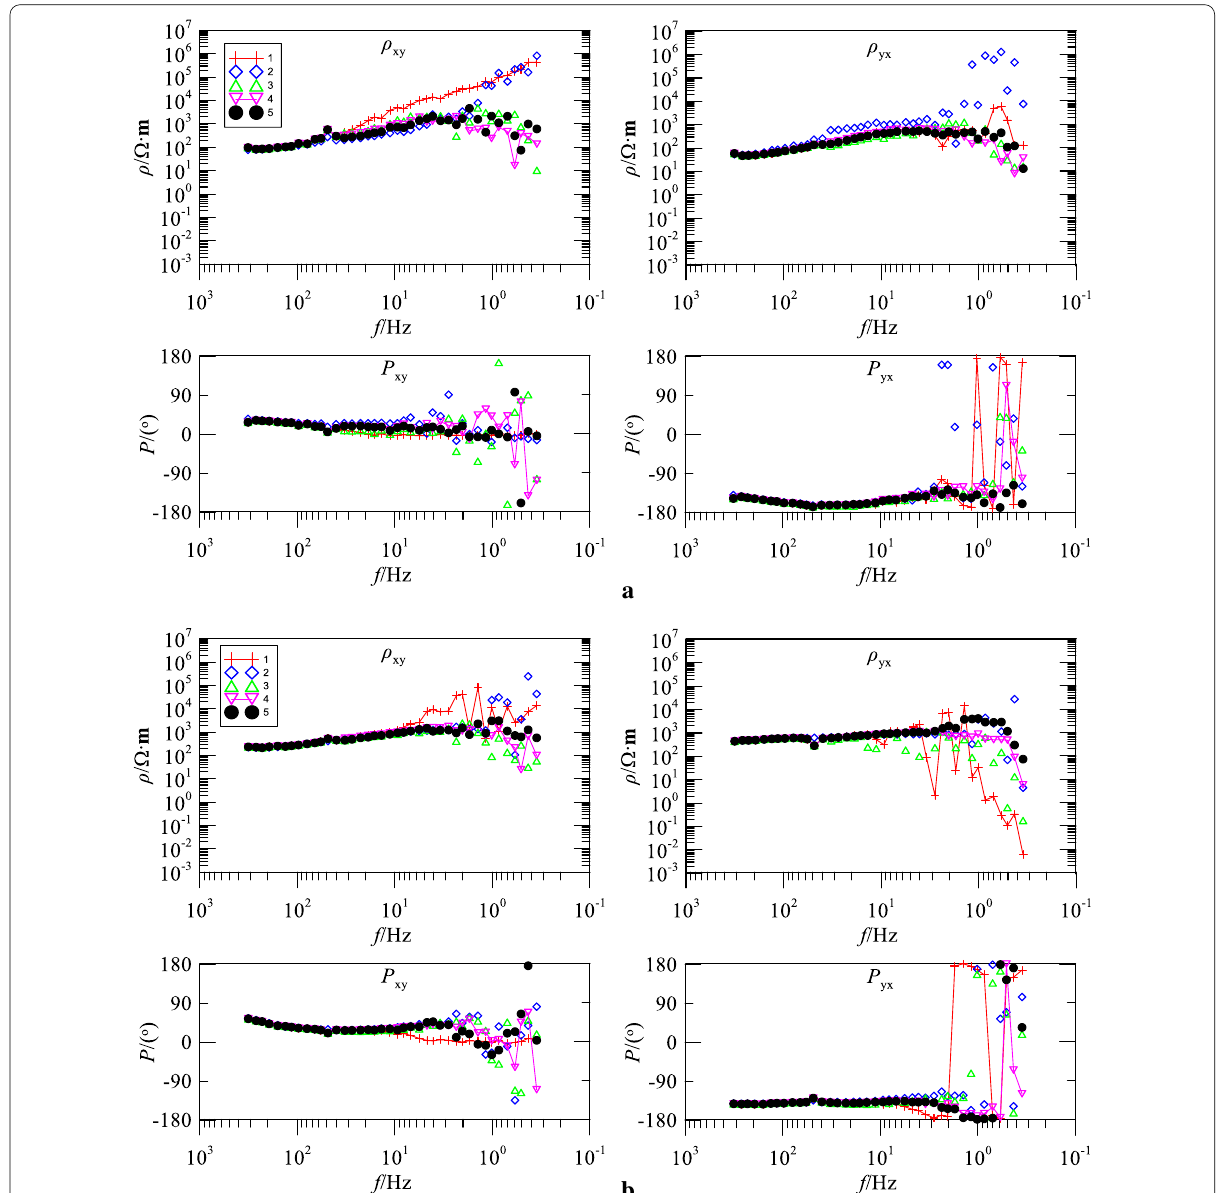
Fig. 7 Comparison of the apparent resistivity-phase curves of the measured AMT site a EL22189 and b EL22174. Among them, curve 1 is the original data, curve 2 is the result obtained by the RR method, curve 3 is the data filtered by the OMP-based overall method, curve 4 is the result derived from the fractal-entropy and clustering method, and curve 5 is the result derived from the proposed